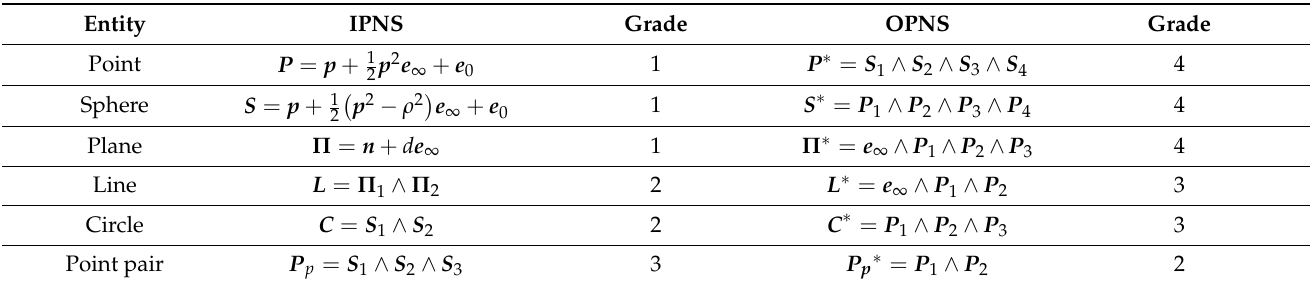
Table 1. The geometric element of